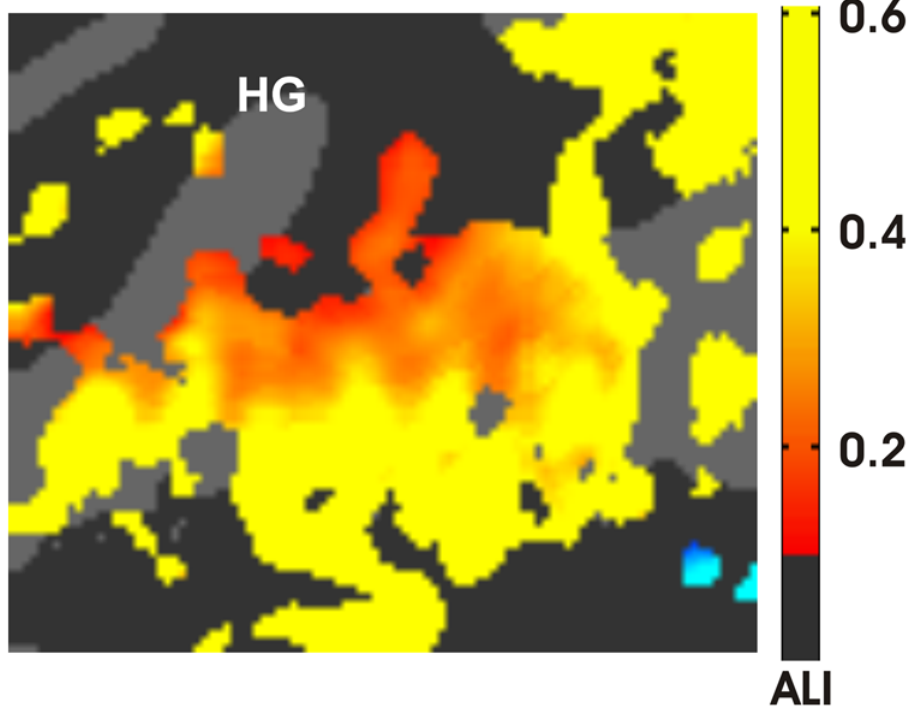
Figure 11. Effects of attention. The attentional lability index (ALI) for areas showing significant attention effects. Data were averaged over sound parameters, hemispheres, subjects, and image acquisition protocols. Activations in blue regions in the STS (lower right) were enhanced during visual attention. HG=Heschl’s Gyrus. z-score threshold=4.0.